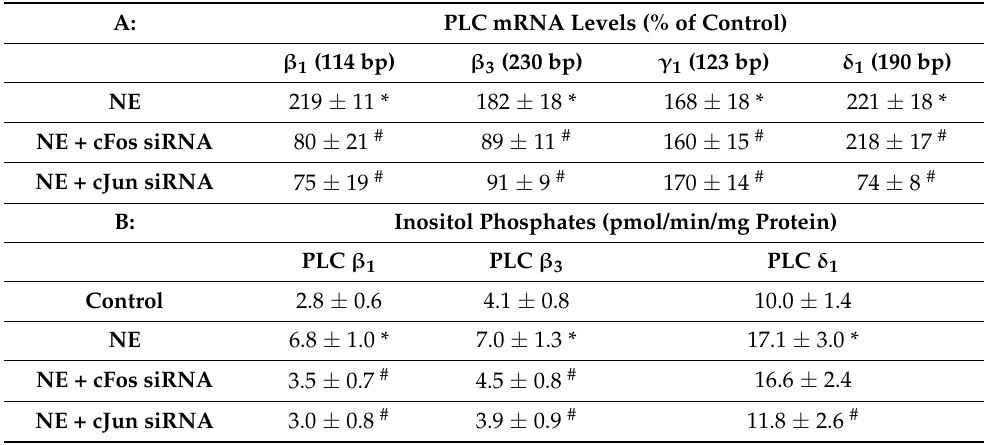
Table 2. Inhibition of norepinephrine the increases in PLC isozyme gene expression (A) and activities (B) in response to norepinephrine in cardiomyocytes transfected with c-Fos and c-Jun